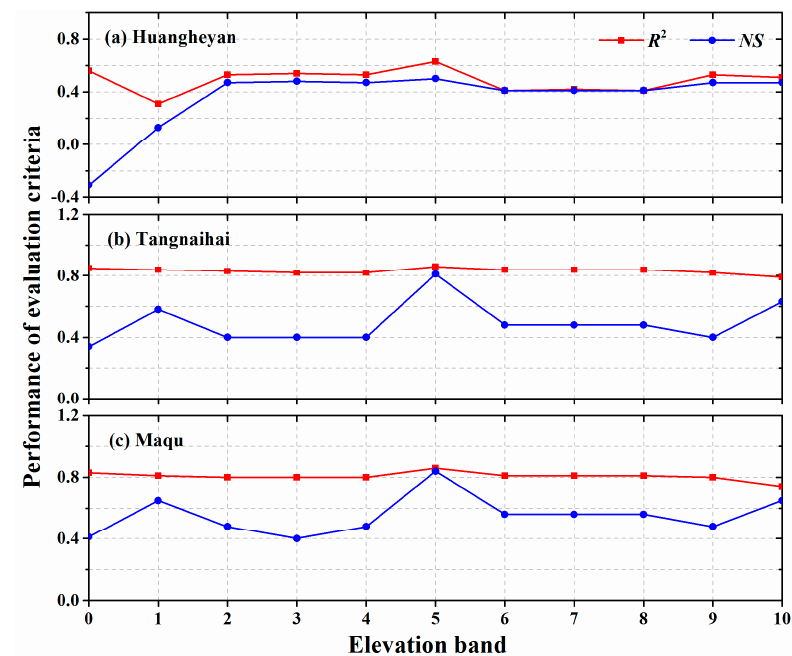
Figure 4. Performance of evaluation criteria (coefficient of determination ( R 2 ) and Nash–Sutcliffe coefficient ( NS) values) for simulations with different numbers of elevation bands during the calibration period (1976–1980 for Huangheyan; 1966–1980 for Tangnaihai and Maqu). Table 3. Model performance evaluation of monthly runoff using different numbers of elevation bands during the calibration period for three gauging stations. Values in parentheses represent statistics for the validation period (1981–1991). Statistics reported are the coefficient of variation ( R 2 ) and the Nash- Sutcliffe coefficient ( NS ).